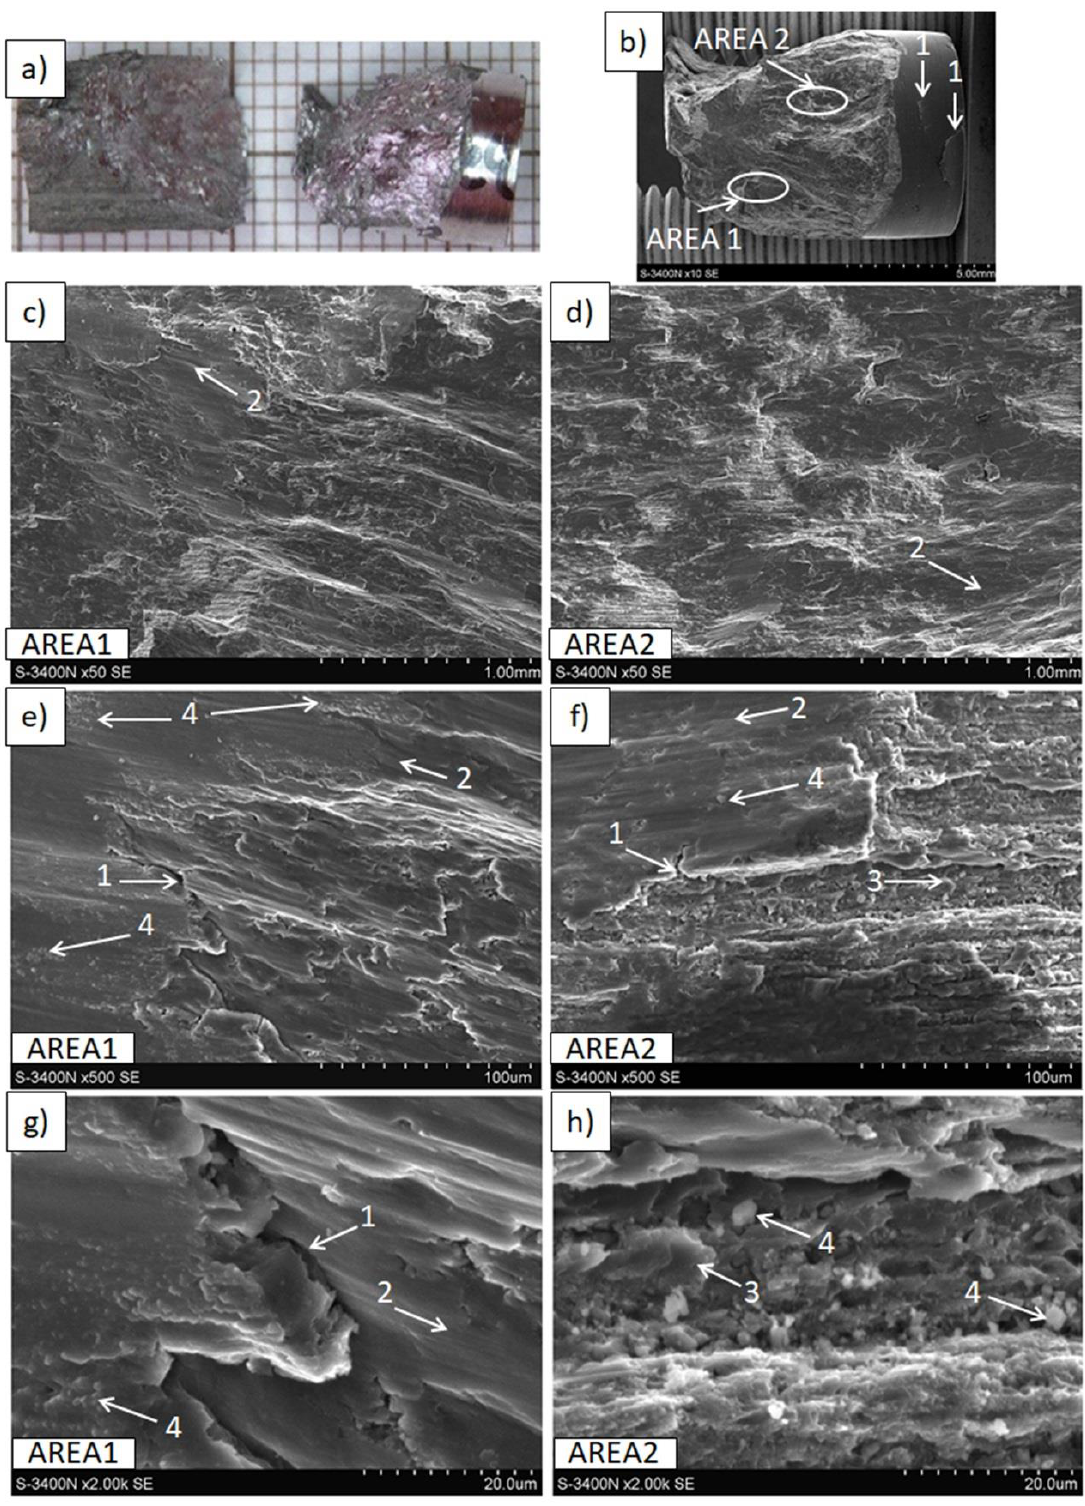
Figure 15. Decohesion effects in the Mg(S) rod after compressive strength test. View of sample ( a , b ) fracture of quasi-brittle type with approx. 45° angle and cracks (1) at the machined surface. SEM micrographs of fracture surface: ( c – h ) cracks (1), smooth areas of metal (2), areas of refined metal (3), and oxides (4).